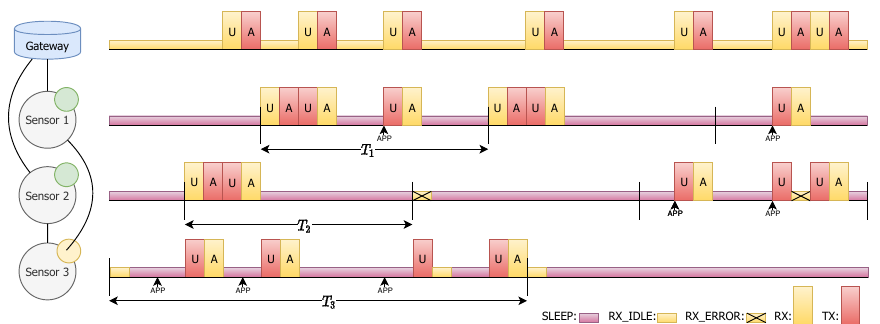
Figure 3. Example of the operation of the JMAC protocol (U → UP_DATA , A → ACK ).